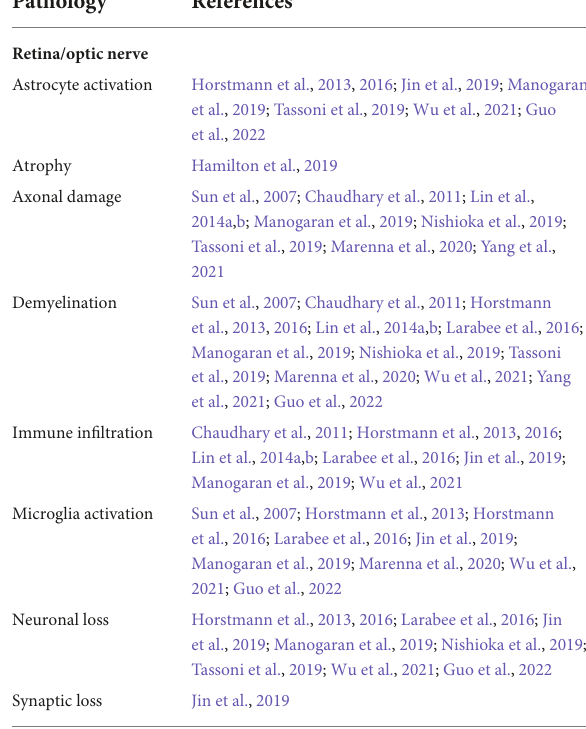
TABLE 6 Pathologies in the retina/optic nerve in